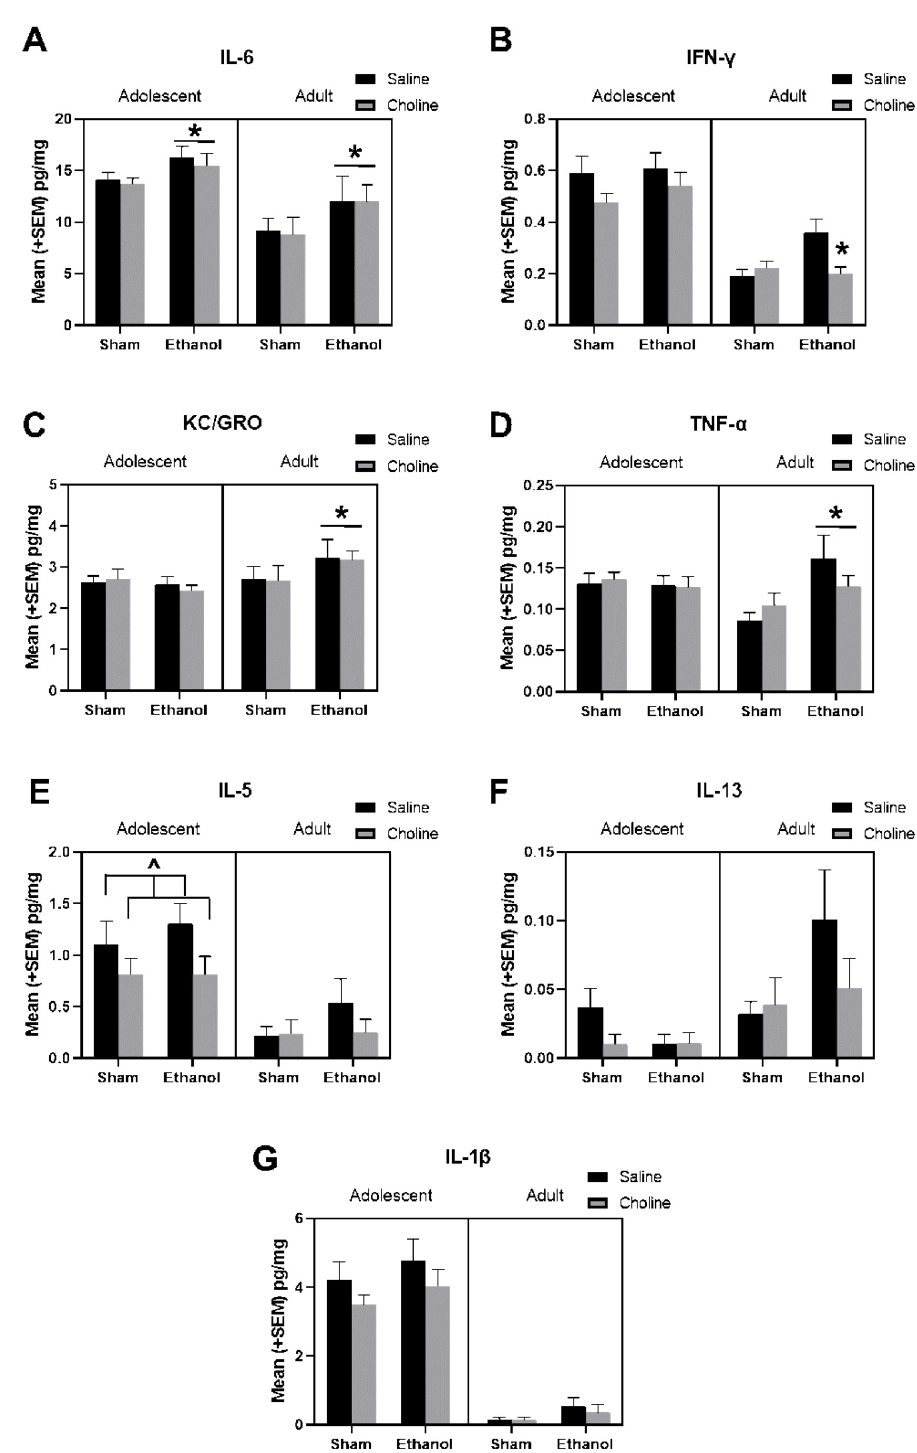
Figure 5. Developmental alcohol exposure and choline supplementation altered levels at cytokines during adolescence and adulthood. The following hippocampal cytokines at adolescence and adult- hood are depicted in the graphs above: ( A ) IL-6 (EtOH > Sham, * p < 0.01; Adolescent > Adult, p < 0.01), ( B ) IFN- γ (EtOH + Choline < EtOH + Saline, * p < 0.05; Adolescent > Adult, p < 0.001), ( C ) KC/GRO (Adult: EtOH > Saline, * p < 0.05), ( D ) TNF- α (Adult: EtOH > Saline, * p < 0.05), ( E ) IL-5 (Adolescent: Choline < Saline, ^ p = 0.07; Adolescent > Adult, p < 0.001), ( F ) IL-13 (Choline < Saline, p = 0.12; Adolescent < Adult, p < 0.05), and ( G ) IL-1 β (Adolescent > Adult, p < 0.001). n = 18–24 per group.